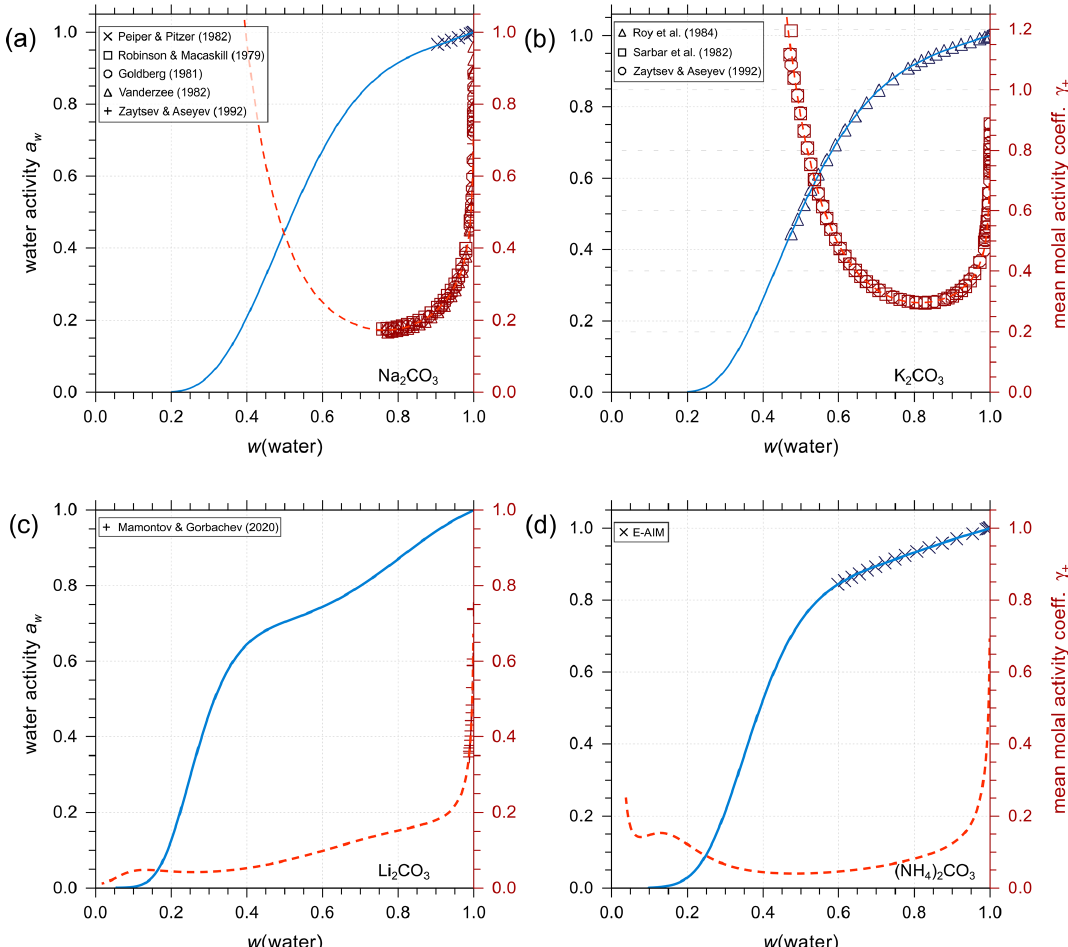
Figure 6. Experimental or reference model data (symbols) and AIOMFAC predictions (curves) of water activity and mean molal activity coefficients of the carbonate electrolytes (a) Na 2 CO 3 , (b) K 2 CO 3 , (c) Li 2 CO 3 , and (d) (NH 4 ) 2 CO 3 in binary aqueous solutions at